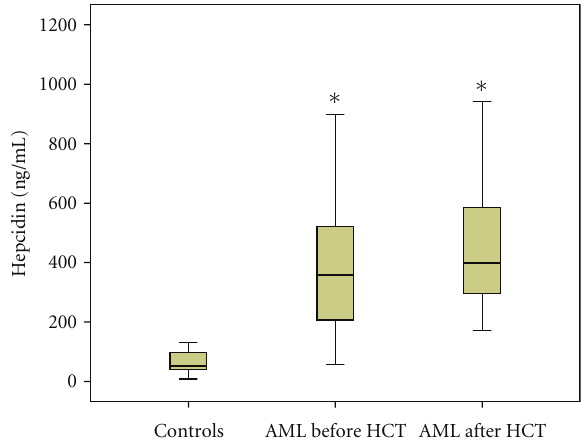
Figure 1: Hepcidin concentrations in controls and in AML patients before and after allogeneic HCT ( n = 42); ∗ P < . 0001, each versus